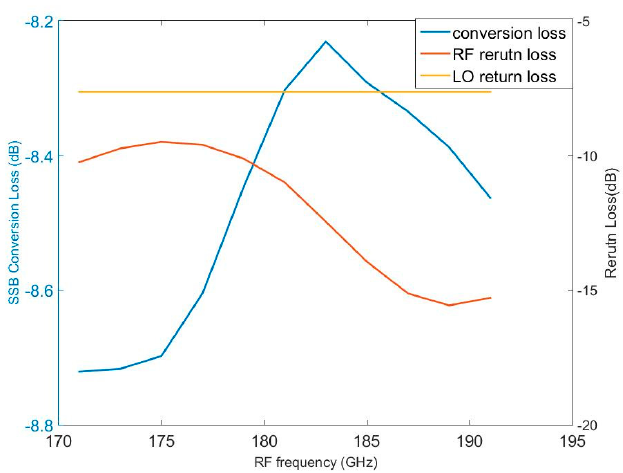
Figure 5. Simulated single-sideband (SSB) conversion loss and return loss of the proposed 183 GHz mixer.